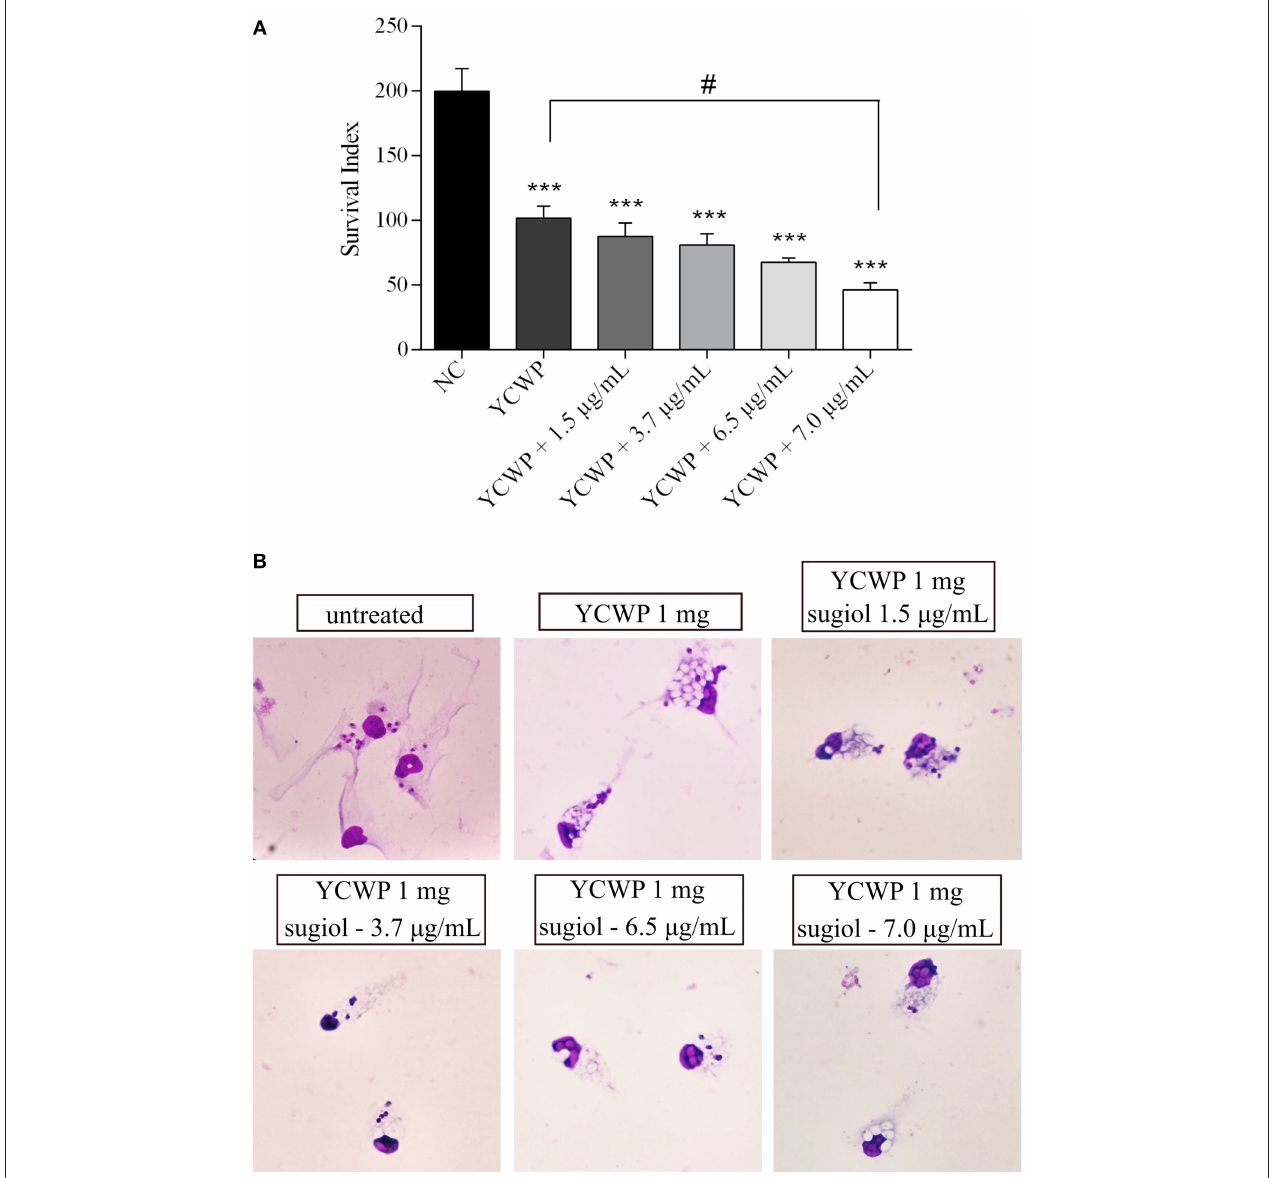
FIGURE 9 | (A) Amastigote survival index within untreated macrophages (NC) and treated with 1 mg/mL of empty YCWPs and 1 mg/mL YCWPs containing different concentrations of sugiol. Three independent experiments were performed and the results were expressed as the mean ± SD. *** p < 0.001, significant difference compared to negative control (NC) group; # p < 0.05, significant difference from YCWPs group. (B) Optical microscopy from untreated and treated infected macrophages. Magnification: